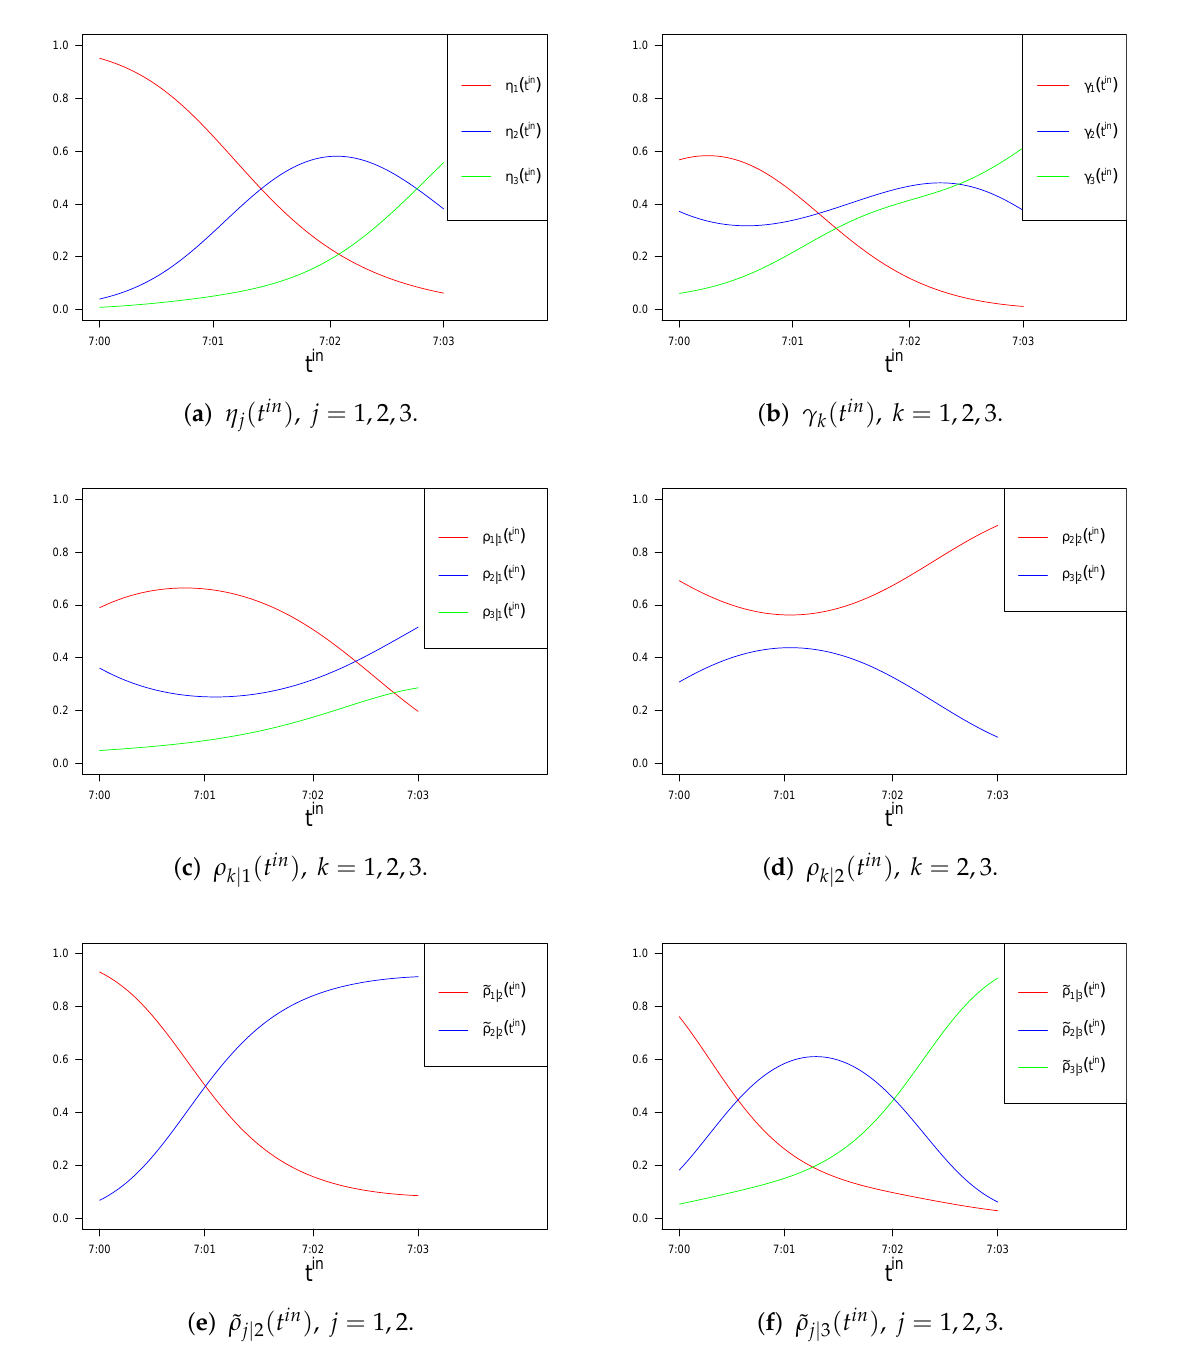
Figure 7. Curves of η j ( t in ) , γ k ( t in ) , ρ k | j ( t in ) , and ˜ ρ j | k ( t in )